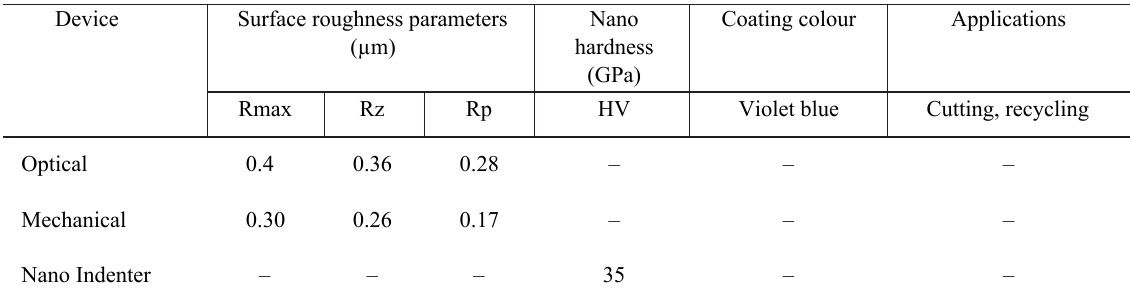
Table 2. Average surface roughness and microhardness of TiAlN coated steel balls for tribological performance Device